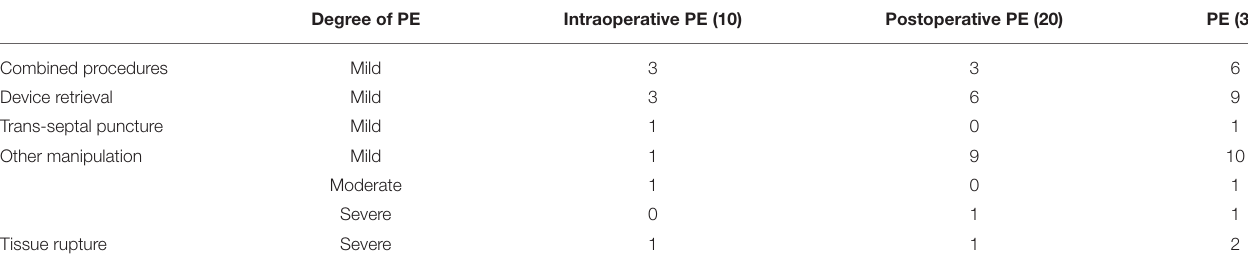
TABLE 3 | The procedural predictors for pericardial effusion (comparison between groups).